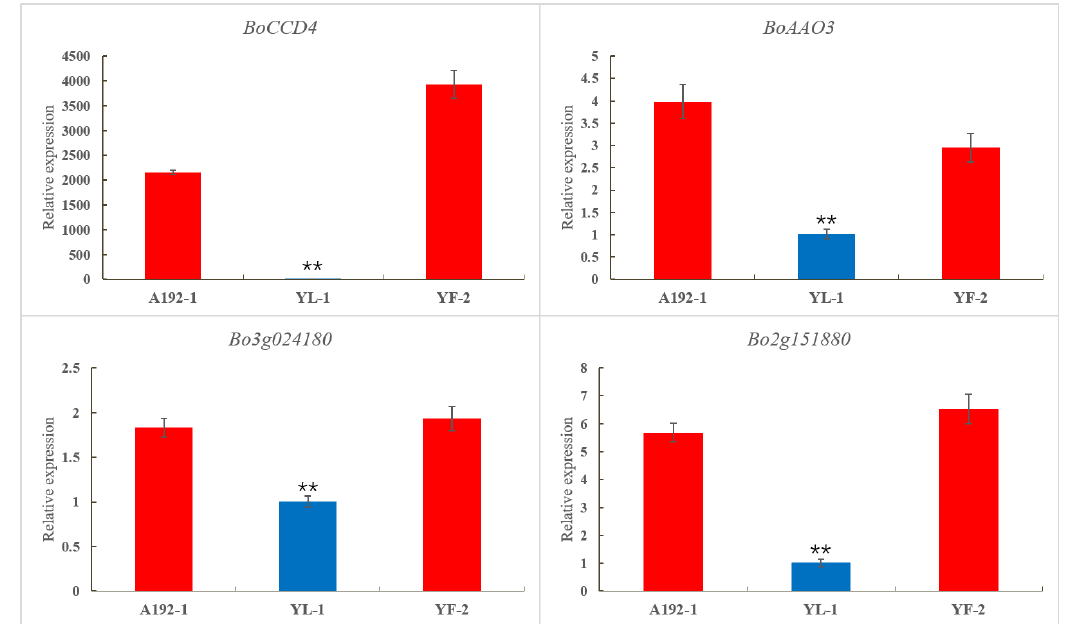
Figure 5. Transcript levels of six key DEGs related to carotenoid metabolism in A192-1, YL-1 and YF-2. The error bars represent the standard errors of three biological replicates. The asterisks represent significant differences ( p < 0.01).